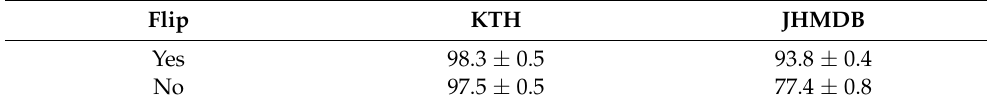
Table 3. Recognition accuracy with and without flip augmentation during